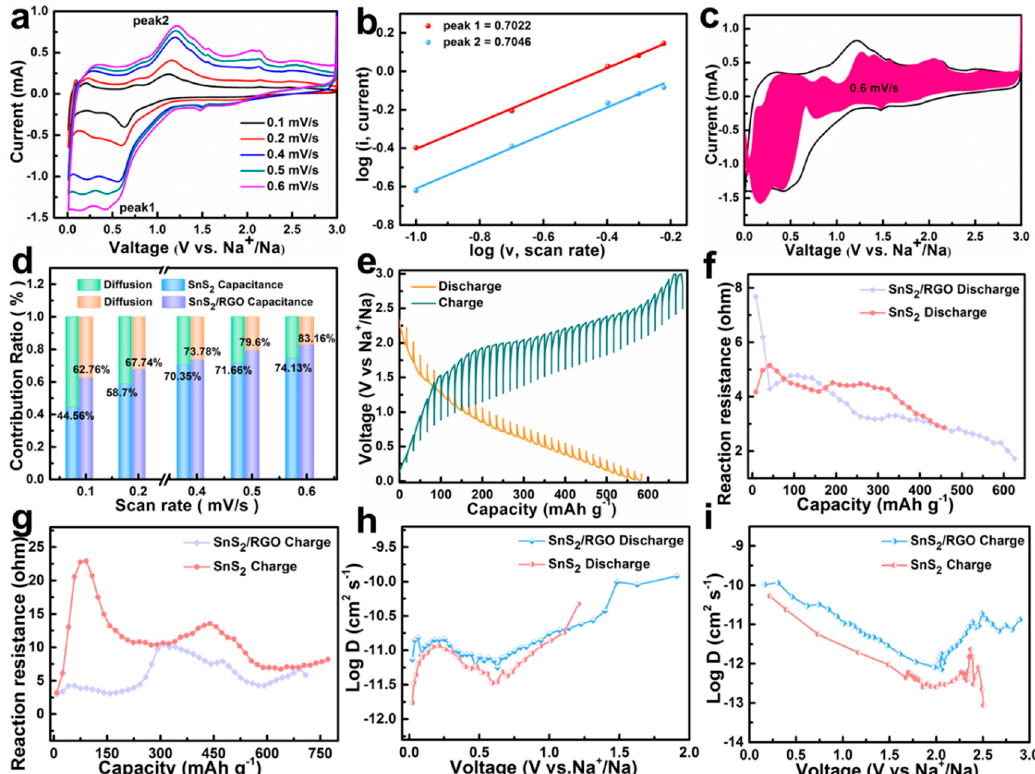
Figure 5. ( a ) CV profiles of SnS 2 /RGO at different sweep rates. ( b ) Linear relationship of log ( i ) vs. log (v) plots at each redox peak. ( c ) CV curve with capacitive and diffusion-controlled contributions at 0.6 mV s − 1 , in which the pseudocapacitive fraction is shown in the red region. ( d ) Normalized contribution ratio of pseudocapacitive at different scan rates. ( e ) GITT voltage profiles of SnS 2 /RGO. ( f , g ) Discharge and charge reaction resistances. ( h , i ) The corresponding D Na values in the first cycle.